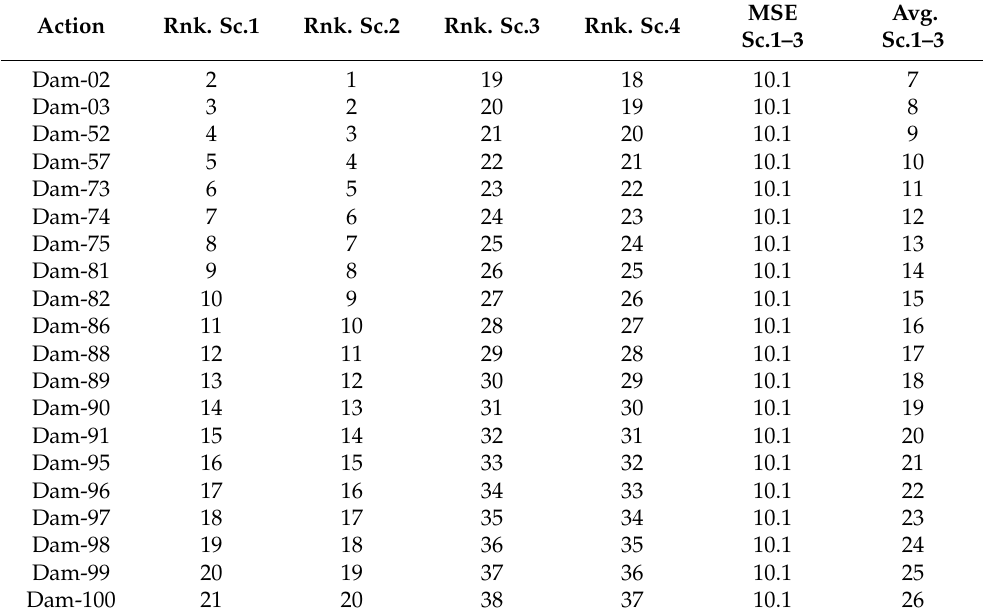
Table A2. Rank position comparison for the scenarios (top 20).